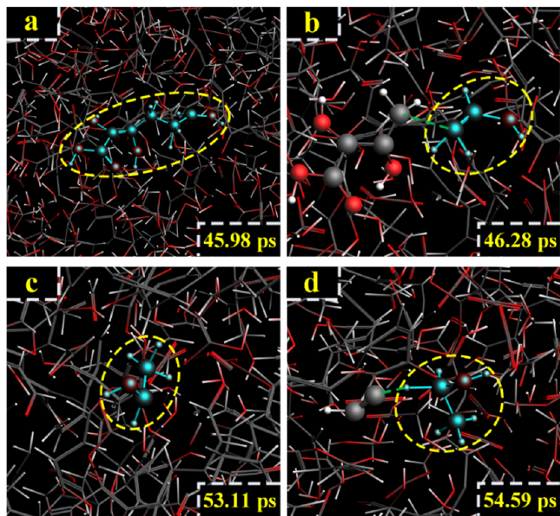
Figure 17. Path IV for the production of ethanol. ( a – d ) are the procedure of LGA to produce ethanol at 2600 K.